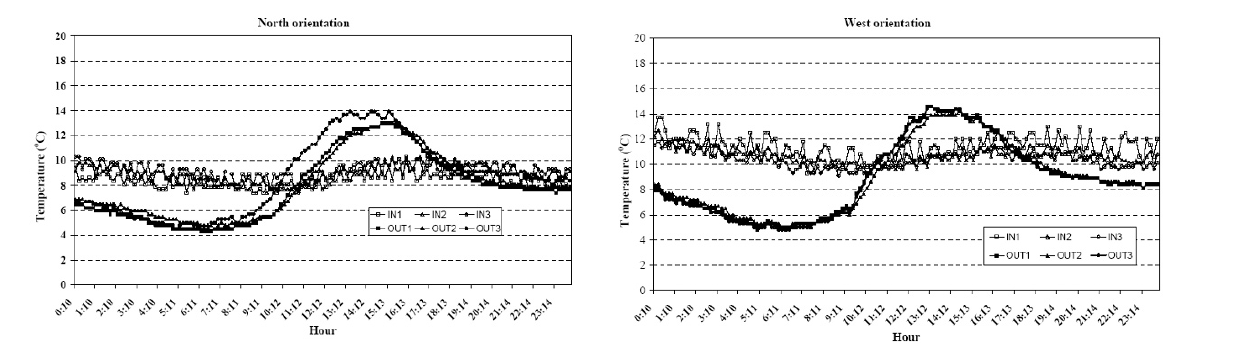
Figure 7. Temperature distribution inside and outside at west wall Winter period .